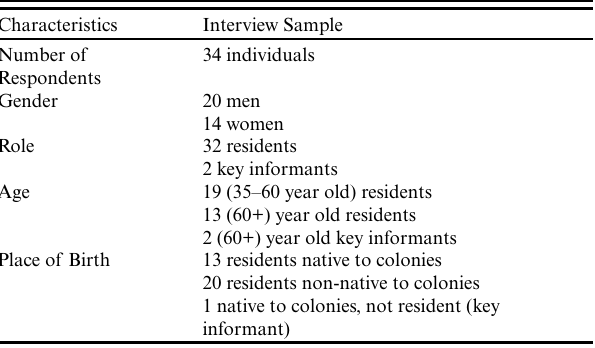
Table 1 . Characteristics of the interview